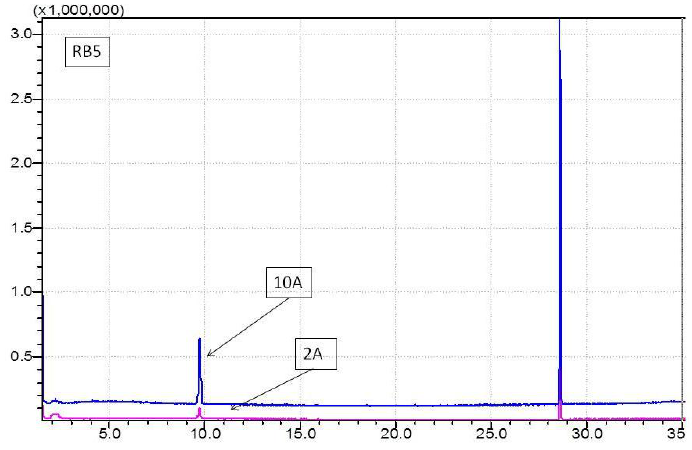
Figure 4. Gas chromatogram for RB5 dye samples treated at 2 A and 10 A.